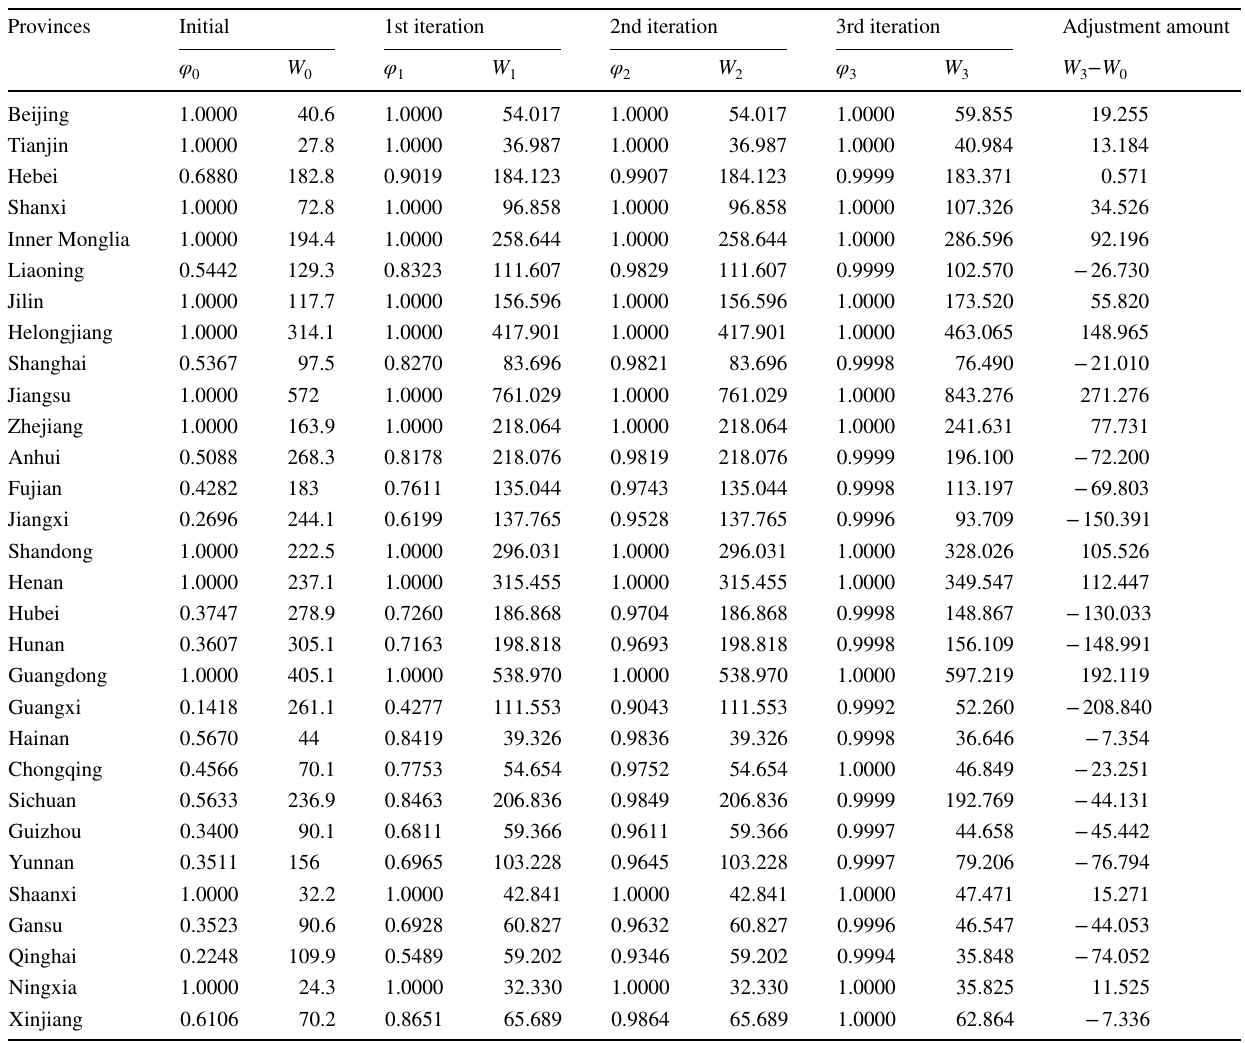
Table 2 ZSG-DEA model efficiency scores of the water of Chinese provinces in 2025